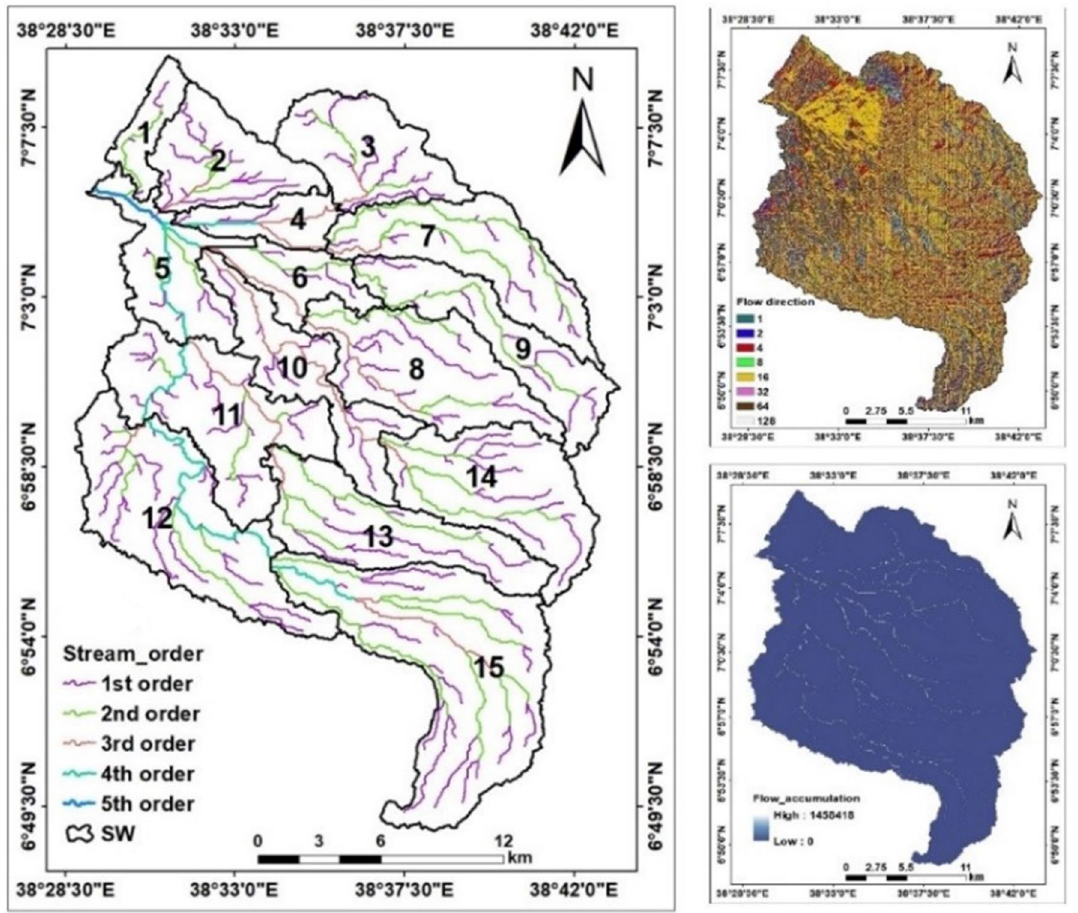
Fig. 2 SW with drainage network (left); flow direction and flow accumulation map